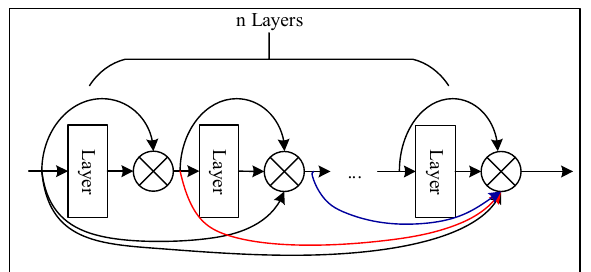
Figure 2. The structure of the dense